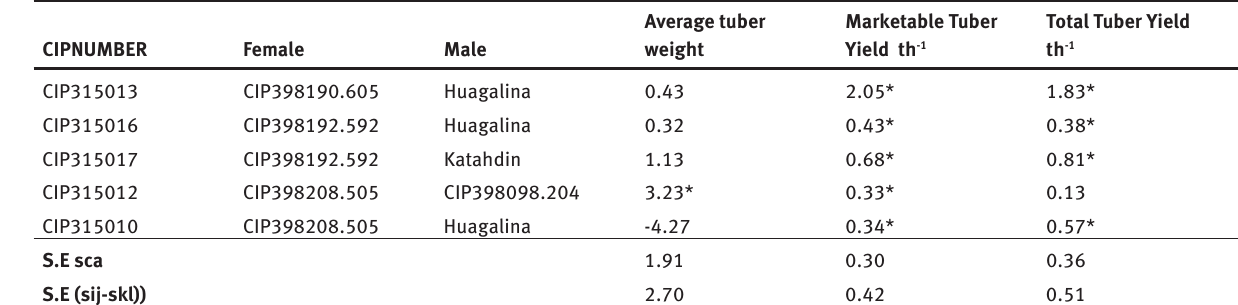
Table 8 continued: Estimates of Specific Combining Ability (SCA) effects in progenies, statistically significant pooled over locations for average tuber weight, marketable and total tuber